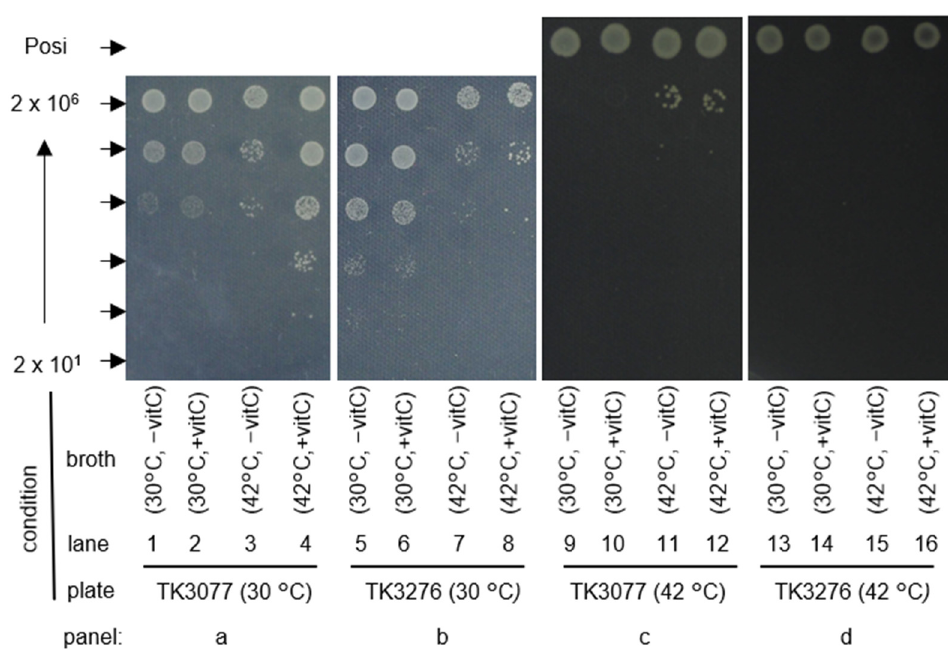
Figure 3. The effects of pretreatment with vitamin C on colony formation of recAts polA cell culture. Cells were spotted with the indicated number of particles on M9GCAA plates. Spots are shown from left to right: liquid cell culture without and with vitamin C at 30 °C and 42 °C. The number of particles between each spot (indicated with arrowheads) ranged from 2 × 10 1 to 2 × 10 6 cells and varied 10-fold at each dilution. A combination of the panels is shown from left to right, pretreatment (broth) at either 30 °C or 42 °C. Plate cultures (plates) were incubated at either 30 °C or 42 °C. Posi indicates 2 × 10 3 cells of AQ10459 for spots on plates at 42 °C.